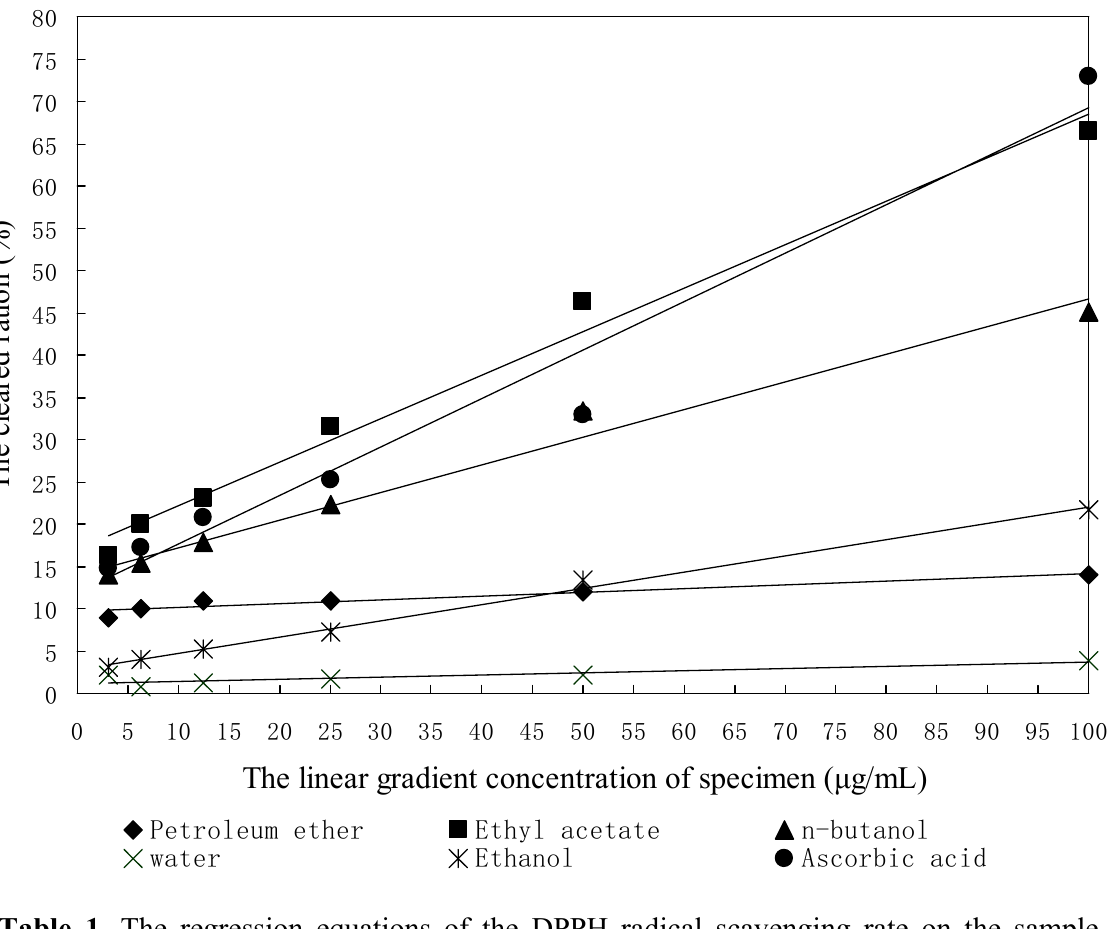
Figure 1. The regression curves of DPPH.